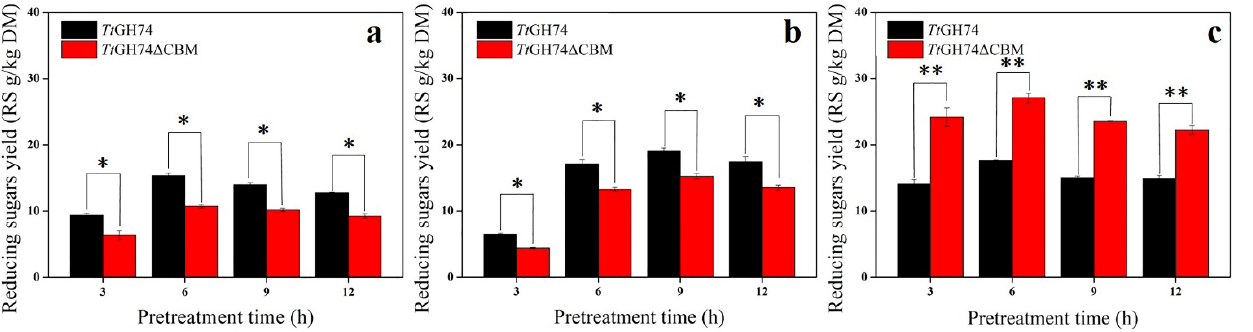
Figure 6. Tt GH74 and Tt GH74ΔCBM enzymatic hydrolysis of sulfuric-acid-pretreated corn bran ( a ), DES-pretreated corn bran ( b ) and DES-pretreated apple pomace ( c ) with different pretreatment times. The product yield was expressed in grams of reducing sugar produced by per kilogram of dry material (Reducing Sugars g/kg Dry Material, RS g/kg DM). The statistical differences between two groups of Tt GH74 and Tt GH74ΔCBM were determined using Student’s t -test analysis. Statistical significance is defined as * p < 0.05 and ** p < 0.01.